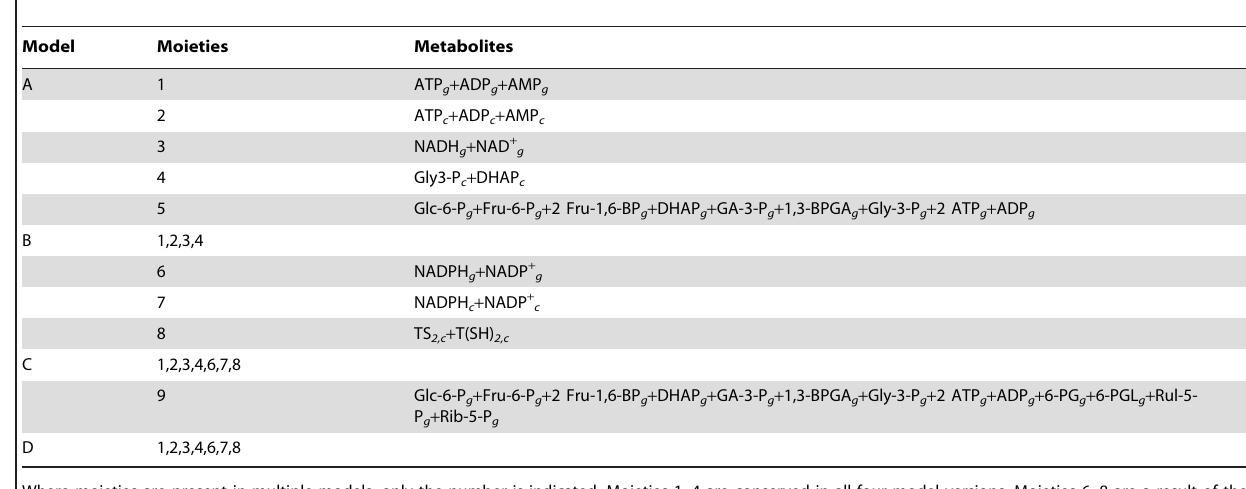
Model B was therefore extended with a glycosomal ribokinase, generating model C (Figure 1), which represents a solution where the glycosomal conserved moiety of bound phosphates is restored (Table 2, moiety 9). In order to provide kinetic parameters for model C, the enzyme kinetics of heterologously expressed T. brucei ribokinase were characterized and used to update the model (see